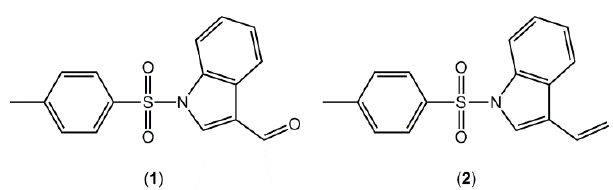
Figure1. Chemical structures of ( 1 ) and ( 2